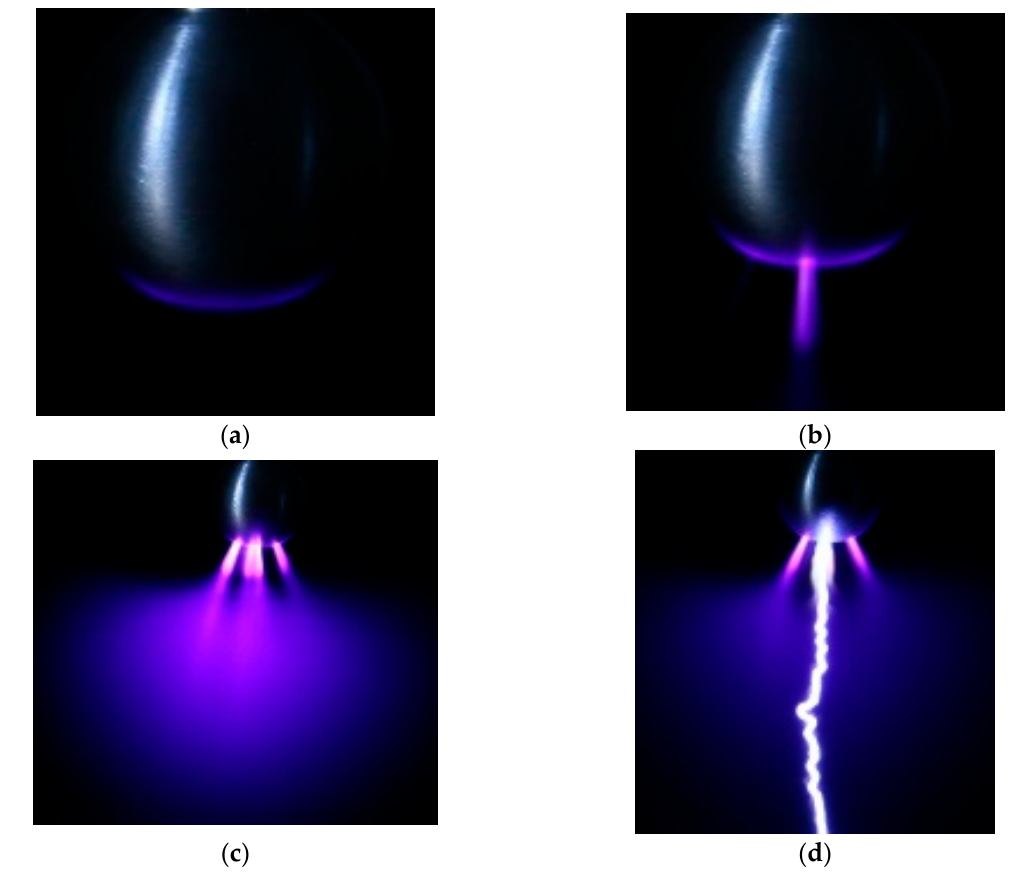
Figure 3. Positive polarity dc corona (sphere diameter of 20 mm, h = 15 cm). ( a ) Initial corona glow at +55.5 kV; ( b ) Corona glow and streamer initiation at +56.0 kV; ( c ) Advanced positive corona combining glow and streamers at +62 kV; ( d ) Spark breakdown at approximately +80 kV. Table 1. Dimensions of Figure